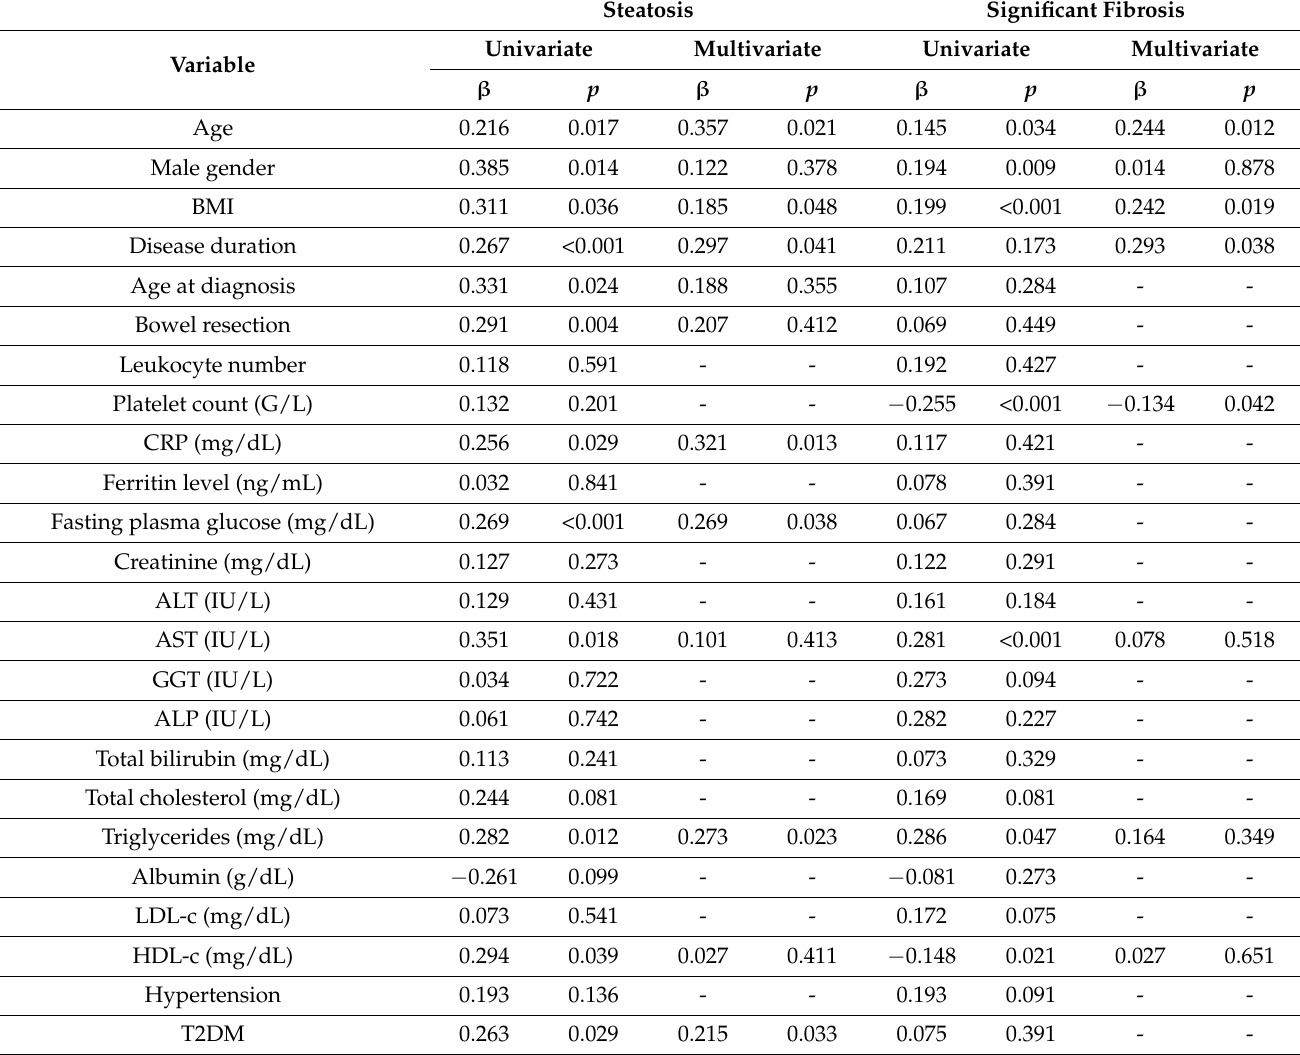
Table 3. Factors associated with hepatic steatosis and significant liver fibrosis using univariate and multivariate linear regression analyses.